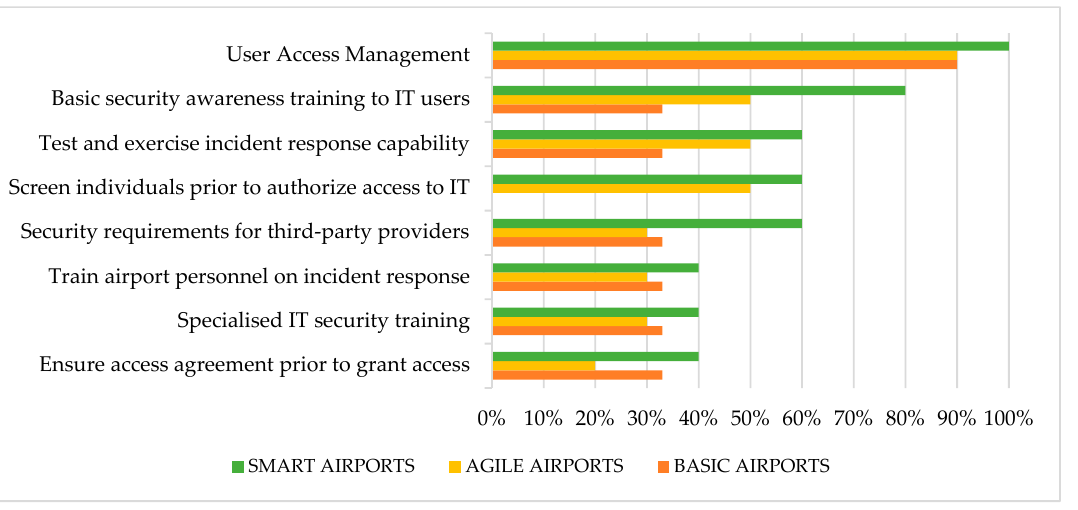
Figure 4. Good practices about airport’s organization and processes.